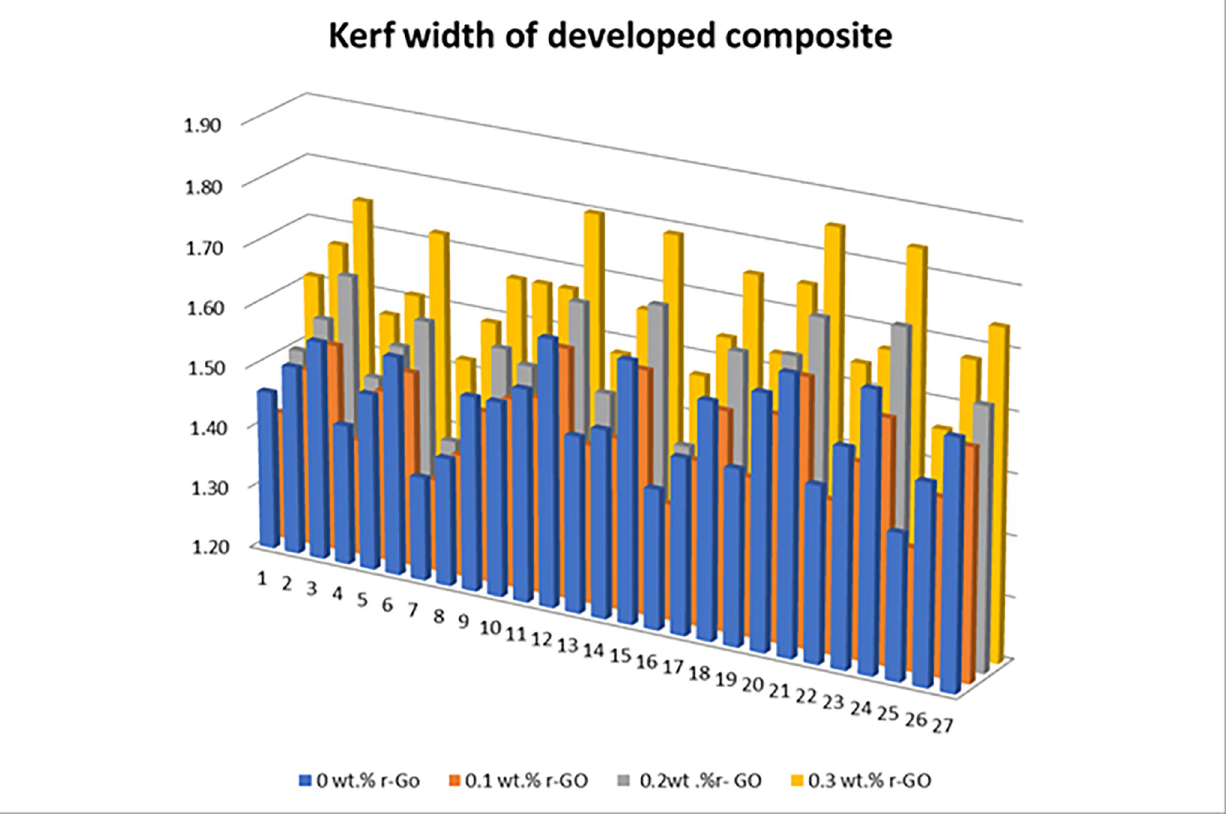
Fig 5. Effect of machining parameter on Kerf width of developed composite.